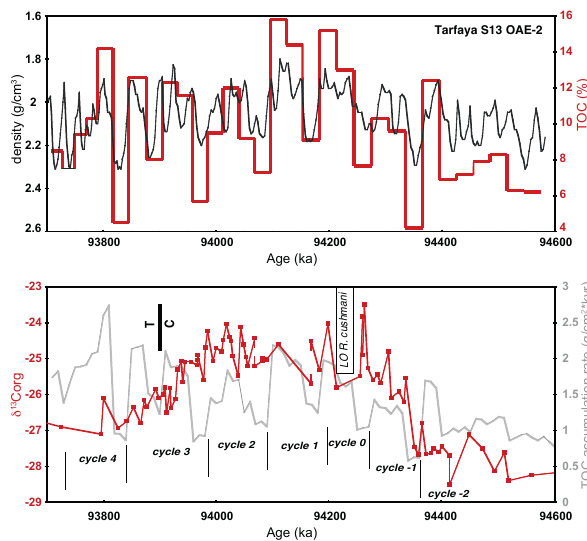
Figure 8. Organic carbon accumulation rates estimated from TOC measurements of 2m continuously sampled and homogenised core sections, and density logging in Tarfaya well S13. Note the maxi- mum between 94.4 and 93.75Ma corresponding to the OAE 2 pos- itive carbon isotope